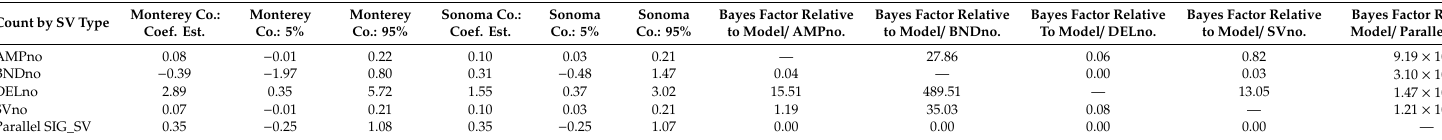
Table 2. Posterior parameter estimates from generalized linear models (binomial distribution with a logit function) of NWT / WT phenotype in response to SV types and their counts (amplification / AMPno., translocation / BNDno., deletion / DELno., all SVs / SVno., and parallel SVs with higher persistence times / Parallel SIG_SV). Median values of coe ffi cients for each county are shown and the 95% Credible Intervals. Bayes factors are calculated for each model relative to an alternative model. CountbySVType MontereyCo.: Coef. Est.